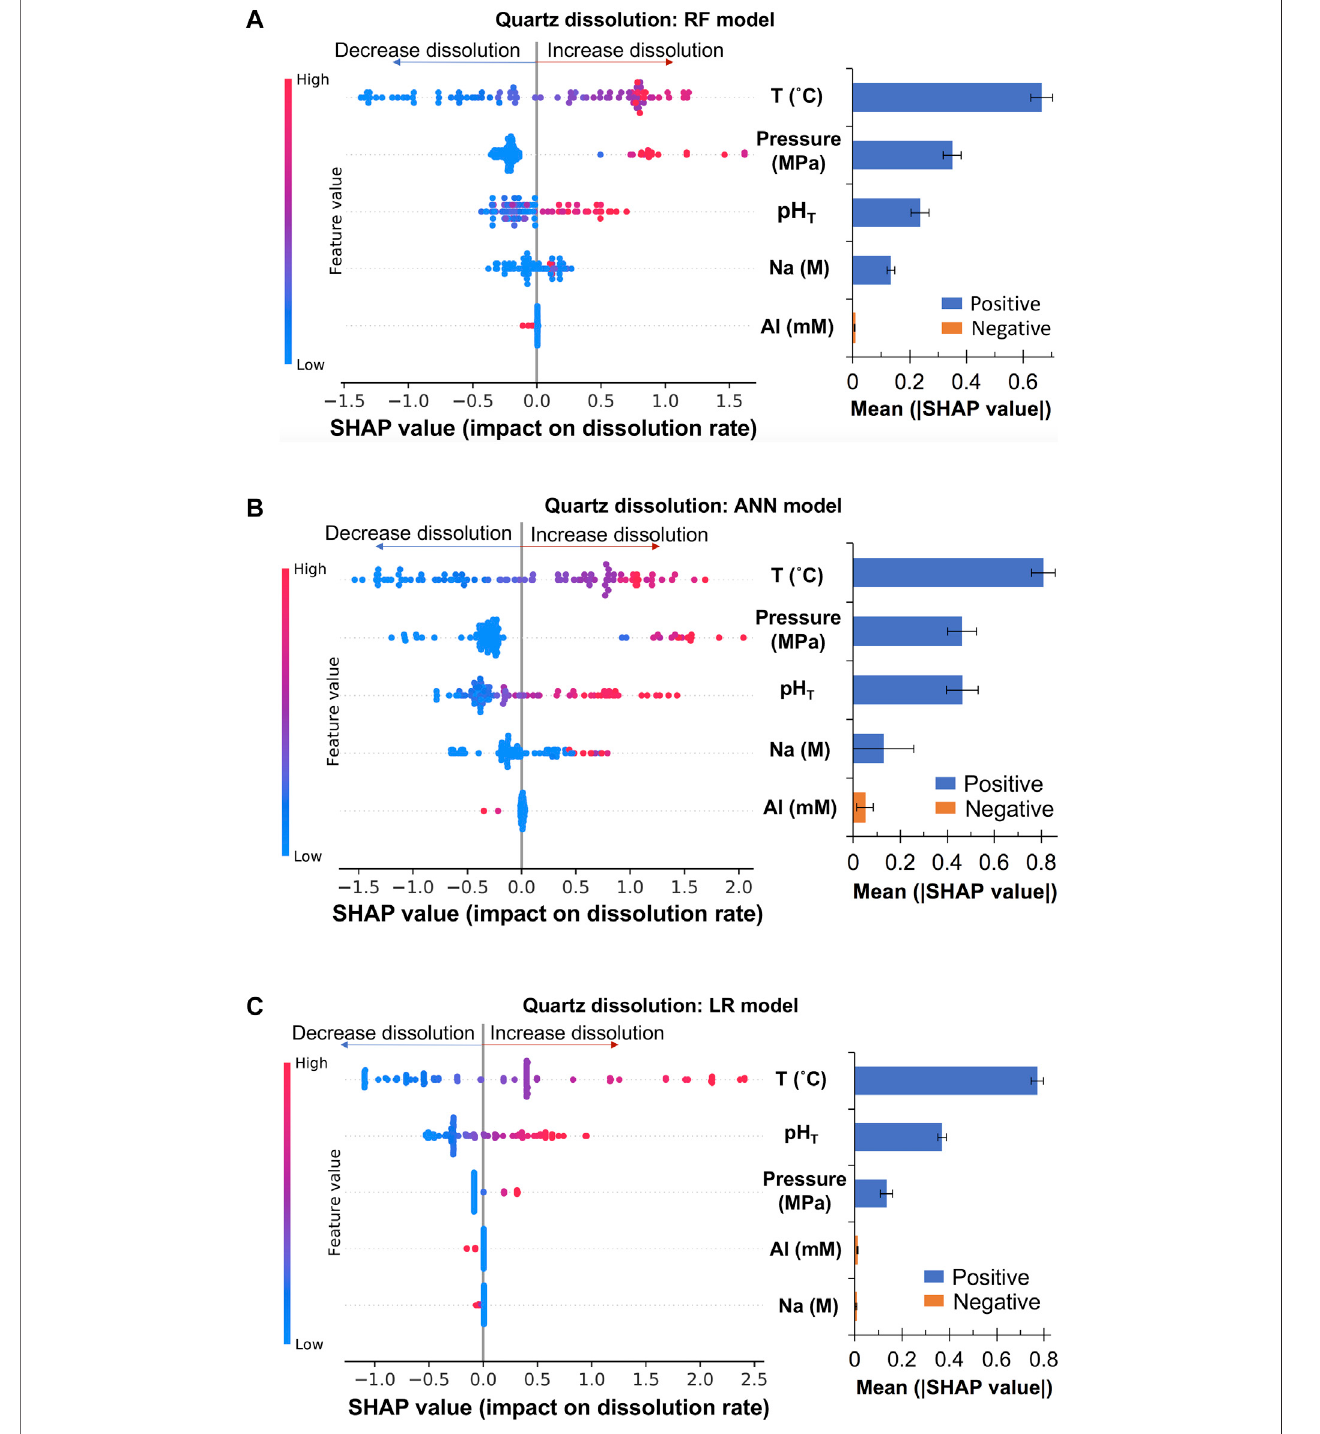
FIGURE 5 | Summary of the SHAP analysis for the (A) RF and (B) ANN and (C) LR models, showing the in fl uence of input features (i.e., fi ve dissolution conditions) onquartzdissolutionrates(i.e.,predictiontarget).TheSHAPvaluesshownarebasedonthe15%testingset,wherethemeanabsoluteSHAPvalueforeachinputfeature is also given on the right panel of the fi gure. The error bars for the mean absolute SHAP value are standard deviations based on twenty independently trained models.